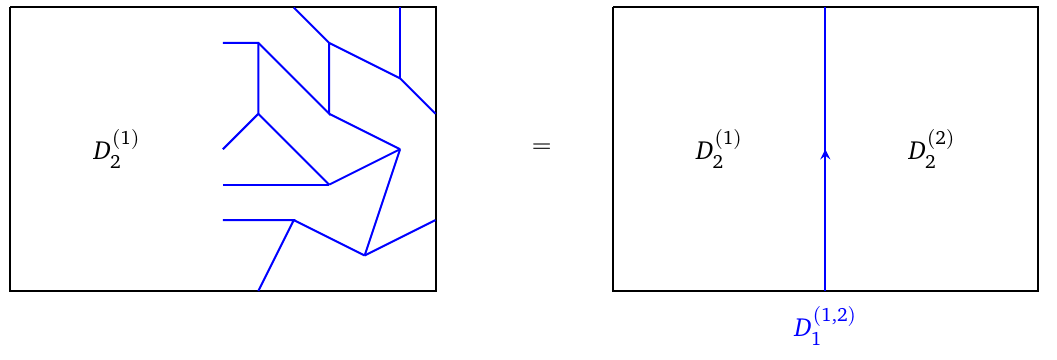
Figure 15: The construction of the interface D p 1,2 q lines on the left hand side are algebra objects A p 1,2 q of the lines are morphisms comprising the